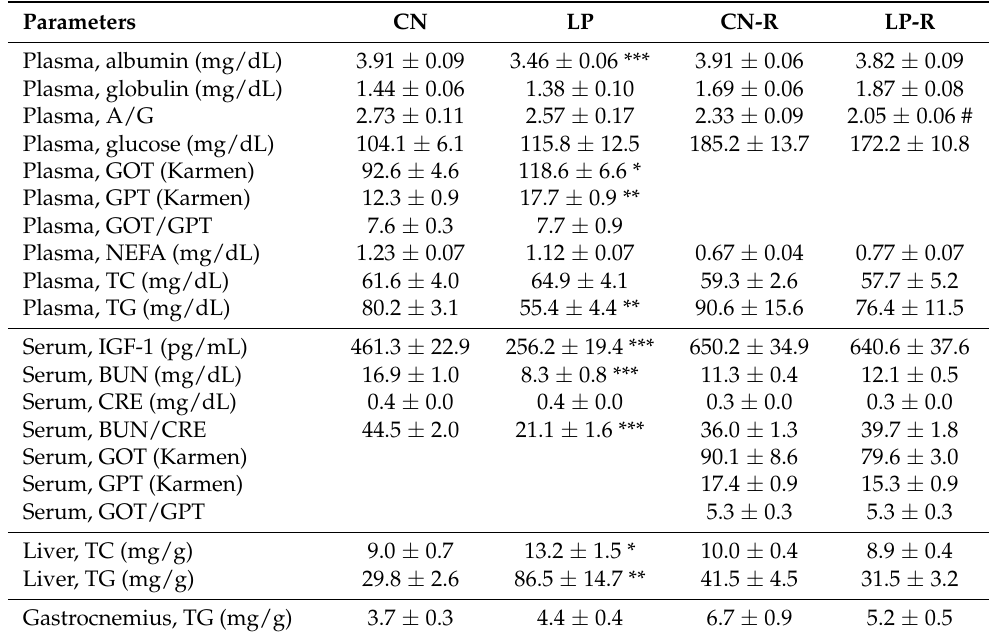
Table 2. Biochemical parameters in the plasma, serum, liver, or gastrocnemius